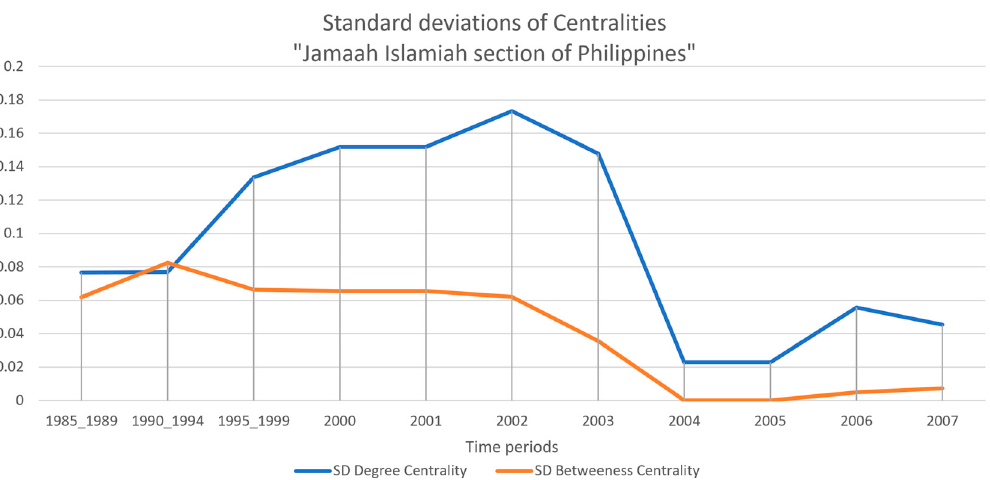
Figure 20. Temporal development of the standard deviation of degree centrality and the standard deviation of betweenness centrality for the “Jamaah Islamiah section of Philippines”. Both indices increase, reach a maximum and then decrease. The average degree centrality reaches a maximum in 2002 and rapidly decreases from 2003 to 2004; it then starts increasing slowly one year later. The average betweenness centrality reaches a maximum in 1994, decreases slowly till 2002, and then rapidly decreasing to zero by 2004, before starting to increase slowly one year later.